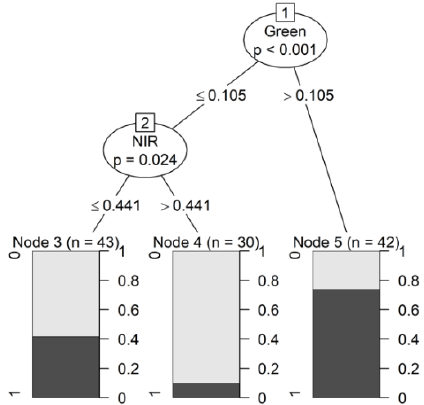
Figure 5. Conditional inference tree model using bands. Terminal node bars represent the proportion (right y-axis) of samples for each soybeans condition at that node. Left y-axis refers to plant condition classes with 0 as asymptomatic and 1 as symptomatic.